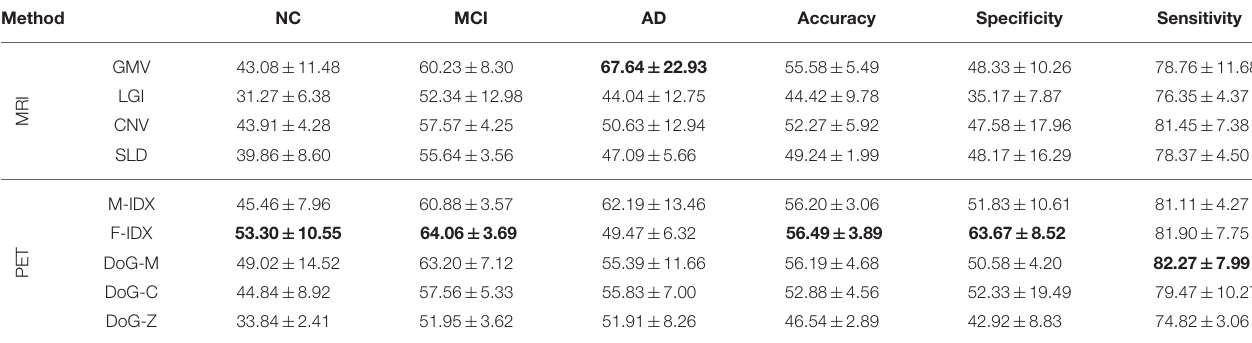
TABLE 2 | The classification performance of single-view biomarkers. Method NC MCI AD Accuracy Specificity